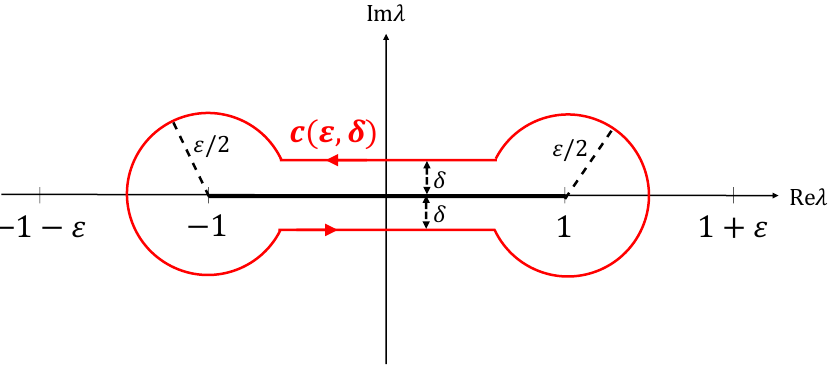
Figure 2: The integration contour used in Eq.